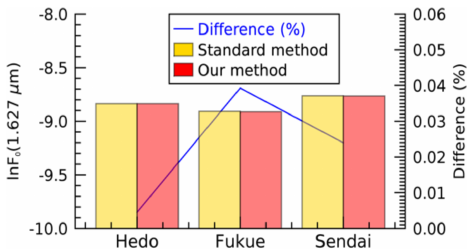
Figure 2. Comparison of the direct intensity calibration con- stant (ln F 0 ) values at the water-absorbing wavelength of 1.627µm for the standard method (calibration using the master instru- ment) and our on-site method for sky radiometers at Hedo- misaki (26.87 ◦ N, 128.25 ◦ E), Fukue-jima (32.75 ◦ N, 128.68 ◦ E), and Sendai (38.26 ◦ N, 140.84 ◦ E). The difference is also shown, which is the difference (as a percentage) between the proposed method and the standard method normalized by the value of the standard method and multiplied by